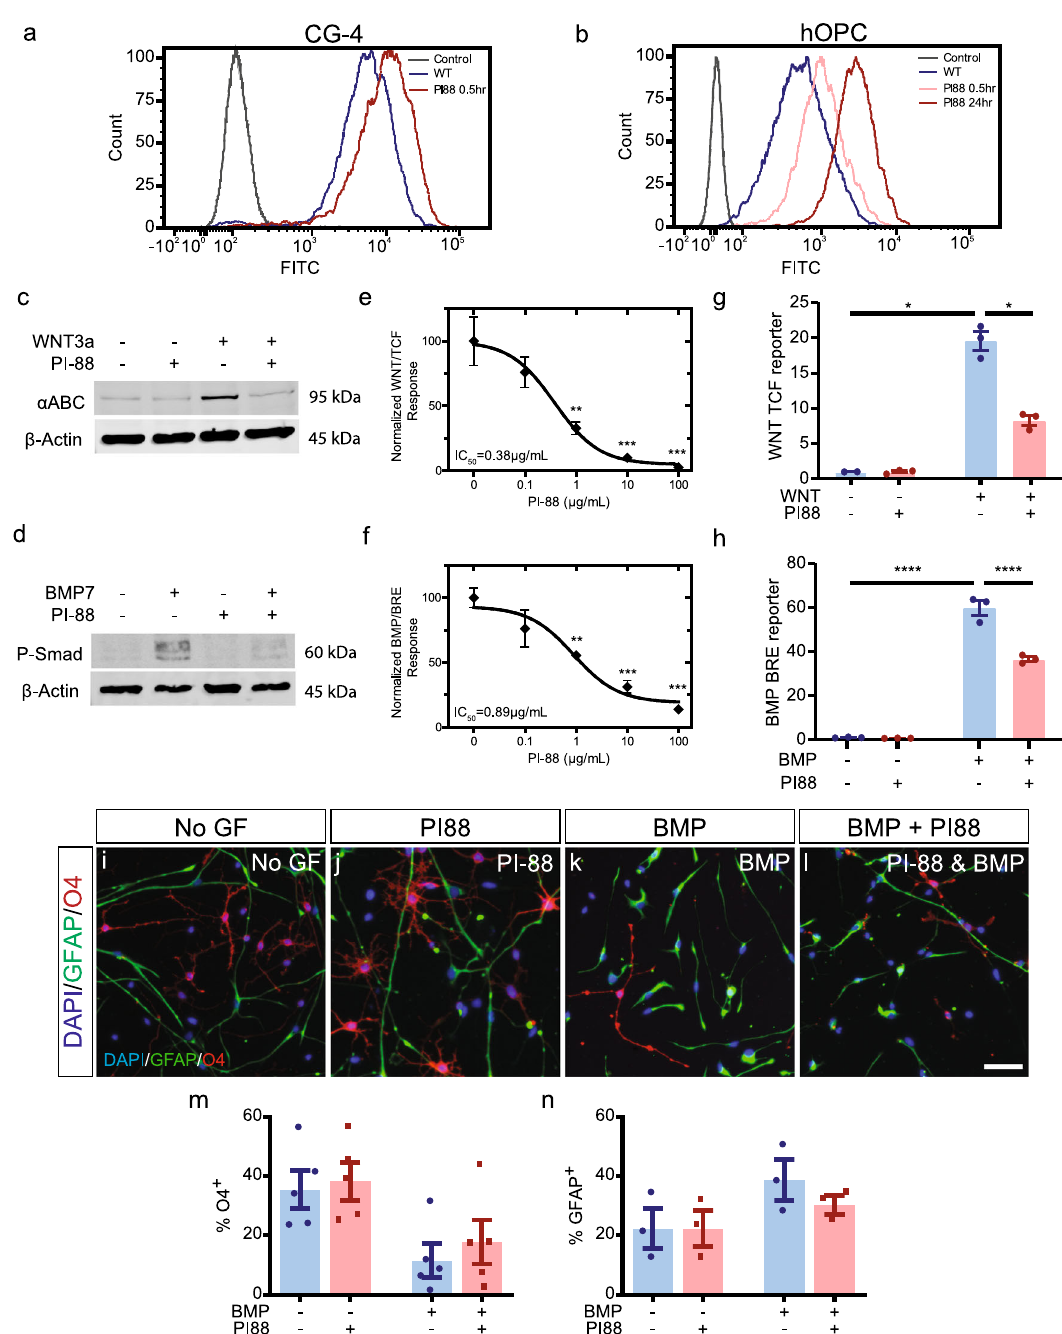
Fig. 6 PI-88 inhibits sulfatases leading to increased HSPG sulfation, and inhibition of WNT and BMP signaling in OPCs. a , b Flow cytometry of HS sulfation using RB4CD12 antibody on rat CG-4 ( a ) and human primary ( b ) OPCs. No antibody control is shown (grey). PI-88 treatment (100 μ g/mL) resulted in a clear increase in OPC sulfation in a time-dependent manner. c , d Western blots for active β -catenin ( α ABC) and phosphorylated Smad 1/5 (p- Smad) following treatment of rat CG-4 OPCs treated with BMP7, WNT3a (both 50 ng/mL), and/or PI-88 (100 μ g/mL). e , f Dose – response curves for WNT and BMP reporter activity in the presence/absence of PI-88 (20 h following treatment, n = 3, one-way ANOVA). ** and *** indicate signi fi cant effect of PI-88 by Dunnett ’ s post-test p < 0.01 and <0.001, respectively. g human primary OPCs were infected with lentiviral TCF reporter and treated with PI-88 (2 µ g/mL) and/or WNT3a (50 ng/mL) ( n = 3 fetal human samples, normalized mean ± SEM). h similarly, hOPCs were infected with BMP response element-dependent reporter and treated with PI-88 and/or BMP7 (n = 3). g , h Two-way ANOVA revealed signi fi cant effects of WNT/BMP and PI-88 treatment, * and **** indicates Sidak ’ s post-test p < 0.05 and <0.001, respectively. i – n The effect of PI-88 treatment on hOPC differentiation was assessed in the context of inhibitory BMP treatment. hOPC were treated with BMP and/or PI-88 and O4 + oligodendrocyte (red) and GFAP + astrocyte (green) differentiation assessed after removal of mitogens. Quanti fi cation of O4% ( m , n = 5 fetal samples) and GFAP% ( n , n = 3 fetal samples). Two-way RM ANOVA revealed signi fi cant effects of BMP and PI-88 on O4 + differentiation (main effect p < 0.05). Mean± SEM is shown. Scale: 50 µ m.